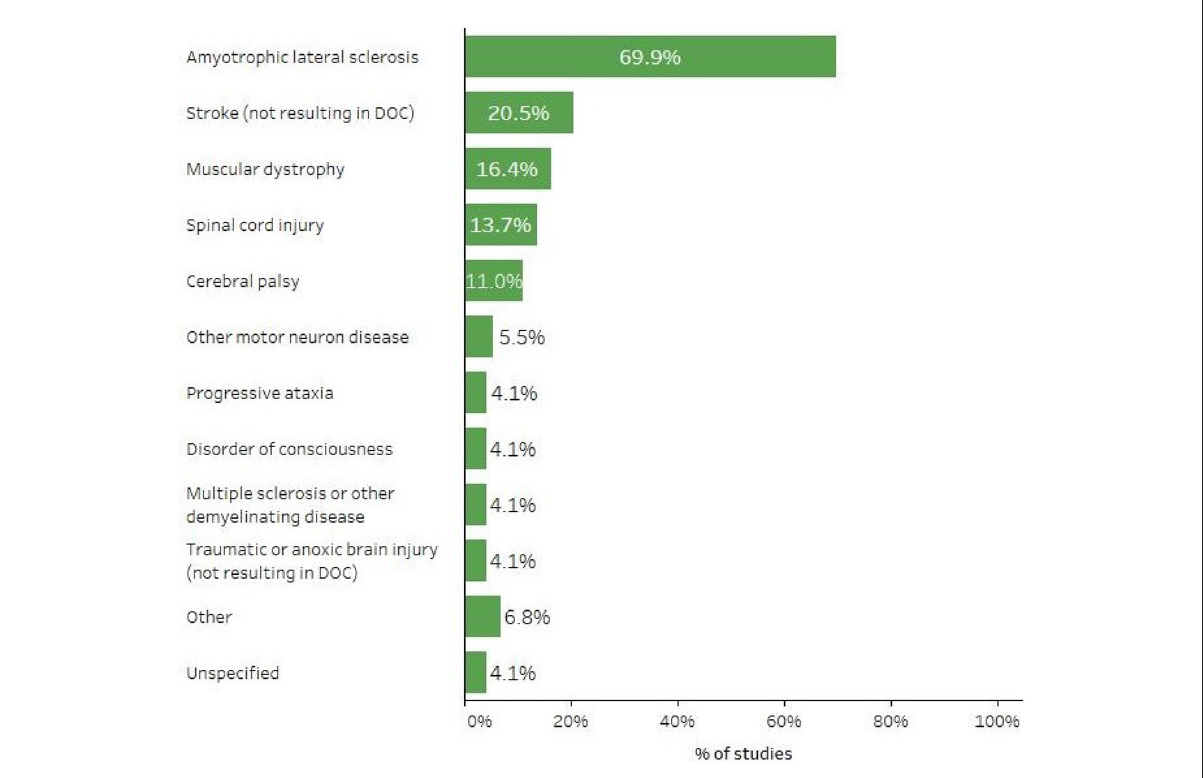
FIGURE5 Percent of studies including participants with specific diagnoses or